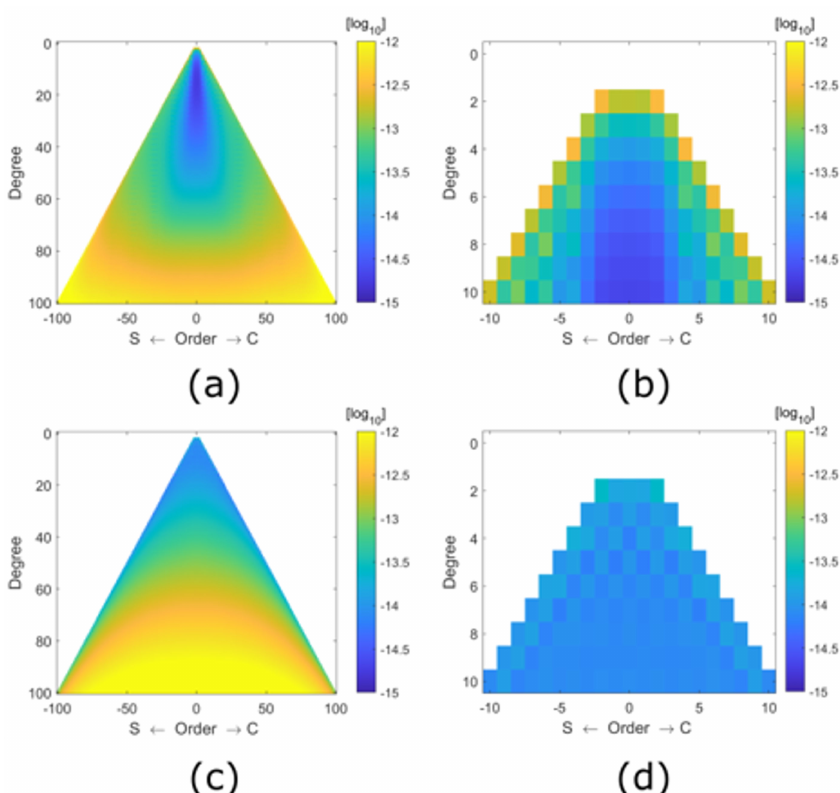
Figure 6. Formal error triangle plots in log up to SH degree and order 100 ( a , c ), and up to SH degree 10 and order 10 ( b , d ), for the low–low pair formation ( a , b ), and the MOBILE constellation ( c , d ). In order to make the effect of the different error spectra of both satellite concepts even more visible, spatial covariance functions were computed for a position at the equator and at 45 ◦ latitude (see Figure 7). They describe the correlation of the computation point with its neighborhood in the normal equation system due to the used stochastic model and the observation geometry. The spatial characteristics and the pattern of the covariances provide information about the spatial behavior of the retrieved signals. In our case, the figures show the typical stripes for the low–low tracking concept caused by the north–south observation direction that are known from the GRACE temporal gravity models, while the MOBILE concept exhibited an isotropic error structure at both